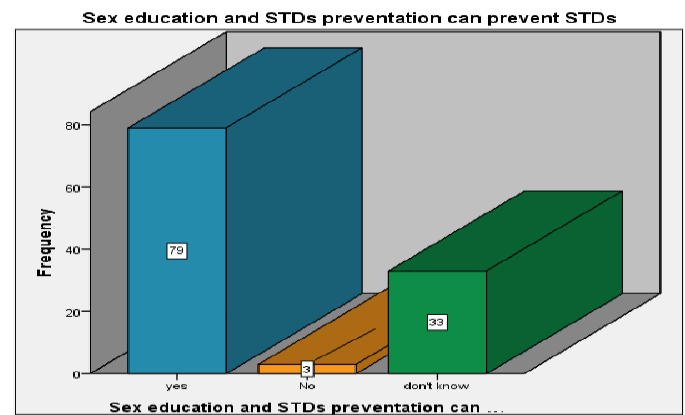
Figure 5: Sex education and STDs prevention